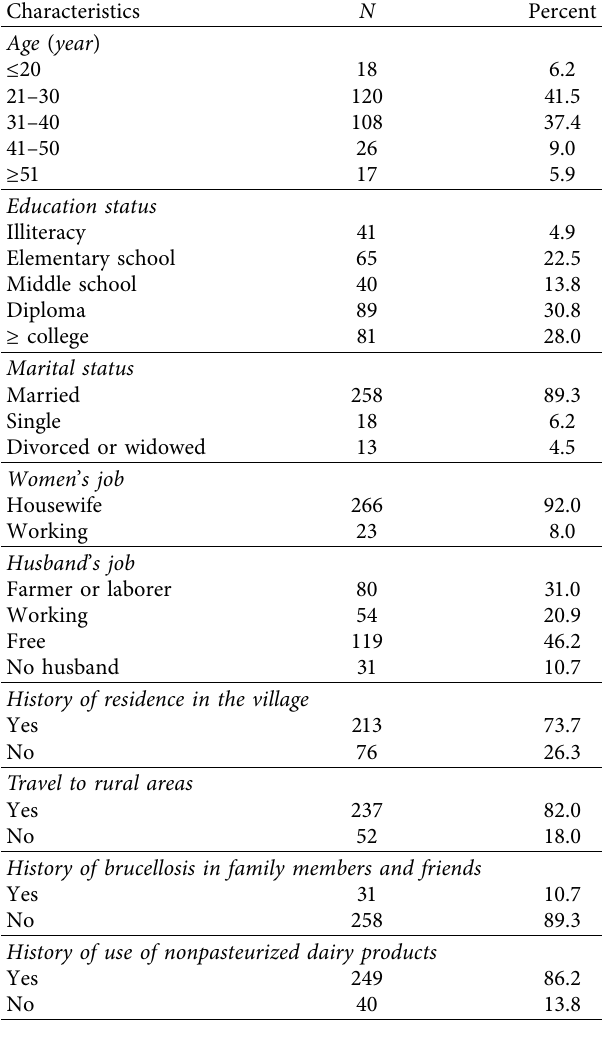
Table 1: Demographic and background characteristics of the participants ( n �